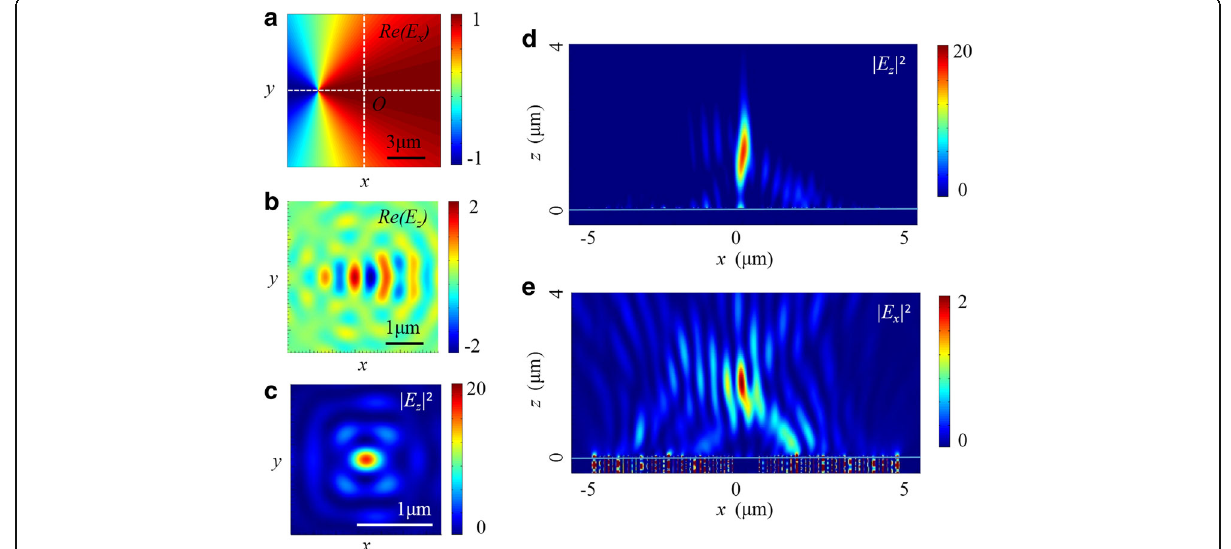
Fig. 14 The intensity distribution of the NRPL in the non-coaxial situation. a The real part of E x of radially polarized incident light. b , c The distribution of Re(E z ) and | E z | 2 in the focal plane. d , e The distribution of | E z | 2 and | E x | 2 in the x-z